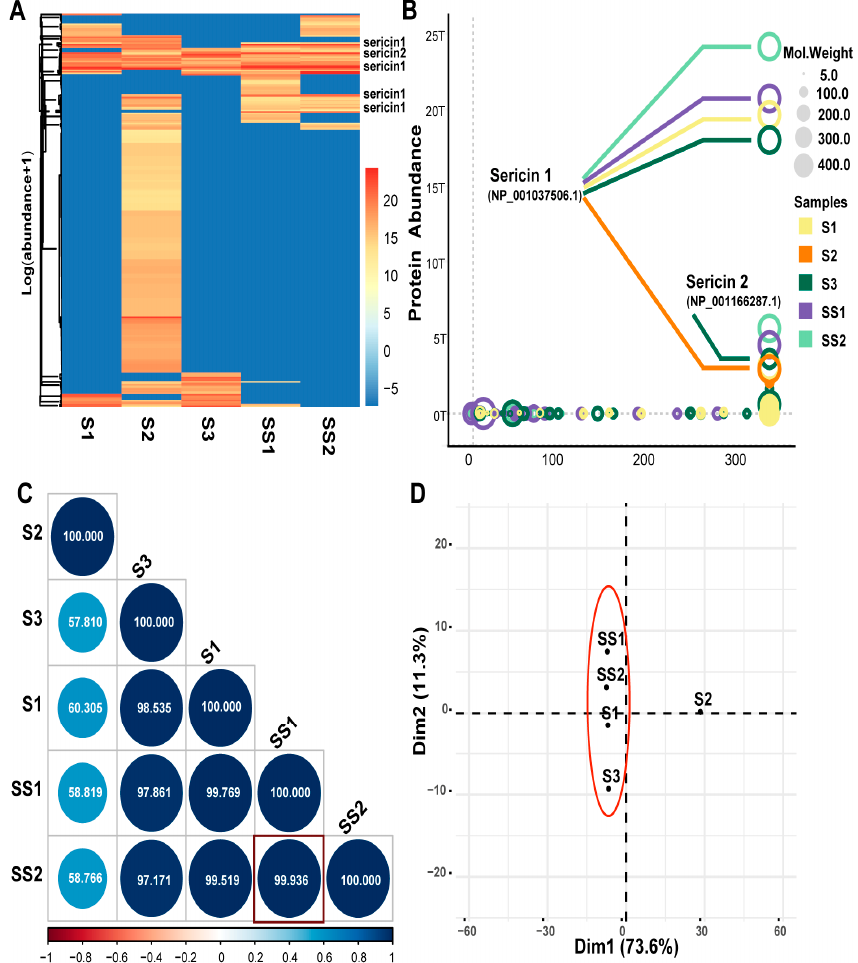
Figure 2. LC-MS/MS analysis of sericin samples. ( A ) The heatmap of protein abundance of the five samples. The protein abundance value was normalized to log (abundance + 1). ( B ) Bubble chart of protein abundance. The color indicates different samples. Bubble size indicates the molecular weight of the protein. The score indicates a comprehensive score of LC-MS/MS data. ( C ) Correlation analysis of protein abundance. Blue indicates a positive correlation and red indicates a negative correlation. The circle size is inversely proportional to the p -value. The number in the circle indicates their similarity. SS1 and SS2 show the strongest correlation (r Pearson = 0.99936, p < 0.001). ( D ) Principal Component Analysis (PCA) of sericin samples. PC1(73.6%) and PC2 (11.3%) were the top 2 principal components.